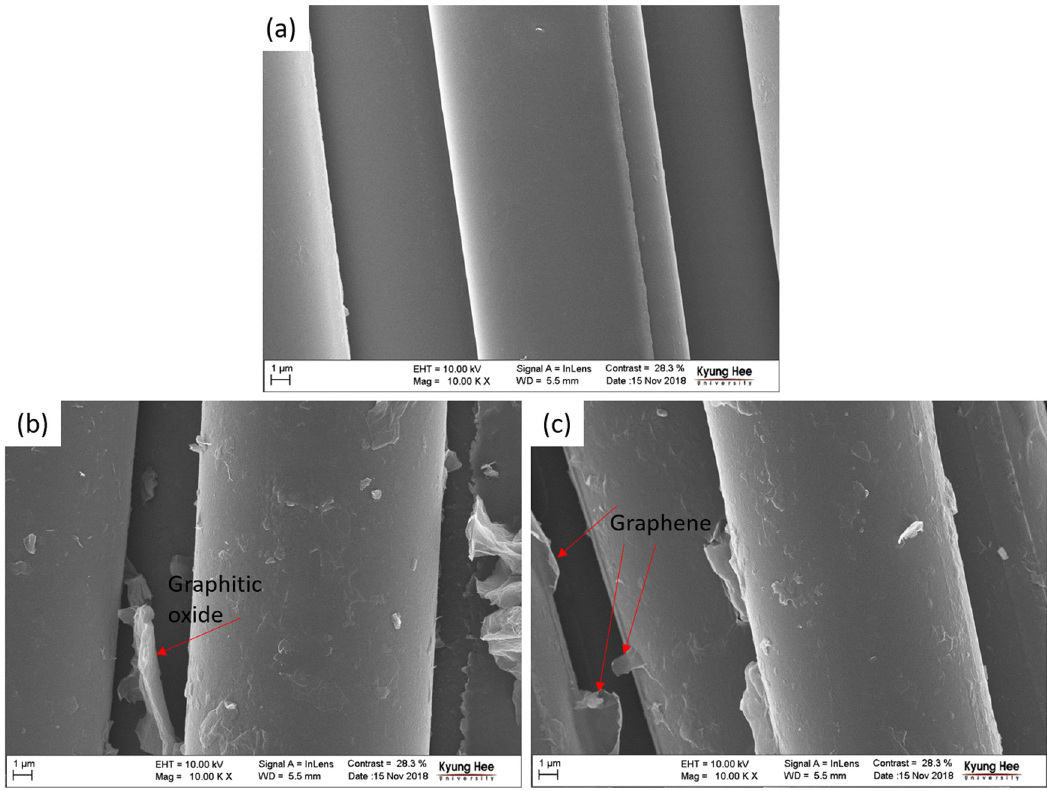
Figure 2: FE - SEM images of: ( a ) bare BF; ( b ) GO - coated BF ( GO - BF ) ; ( c ) graphene - coated BF ( rGO - BF )